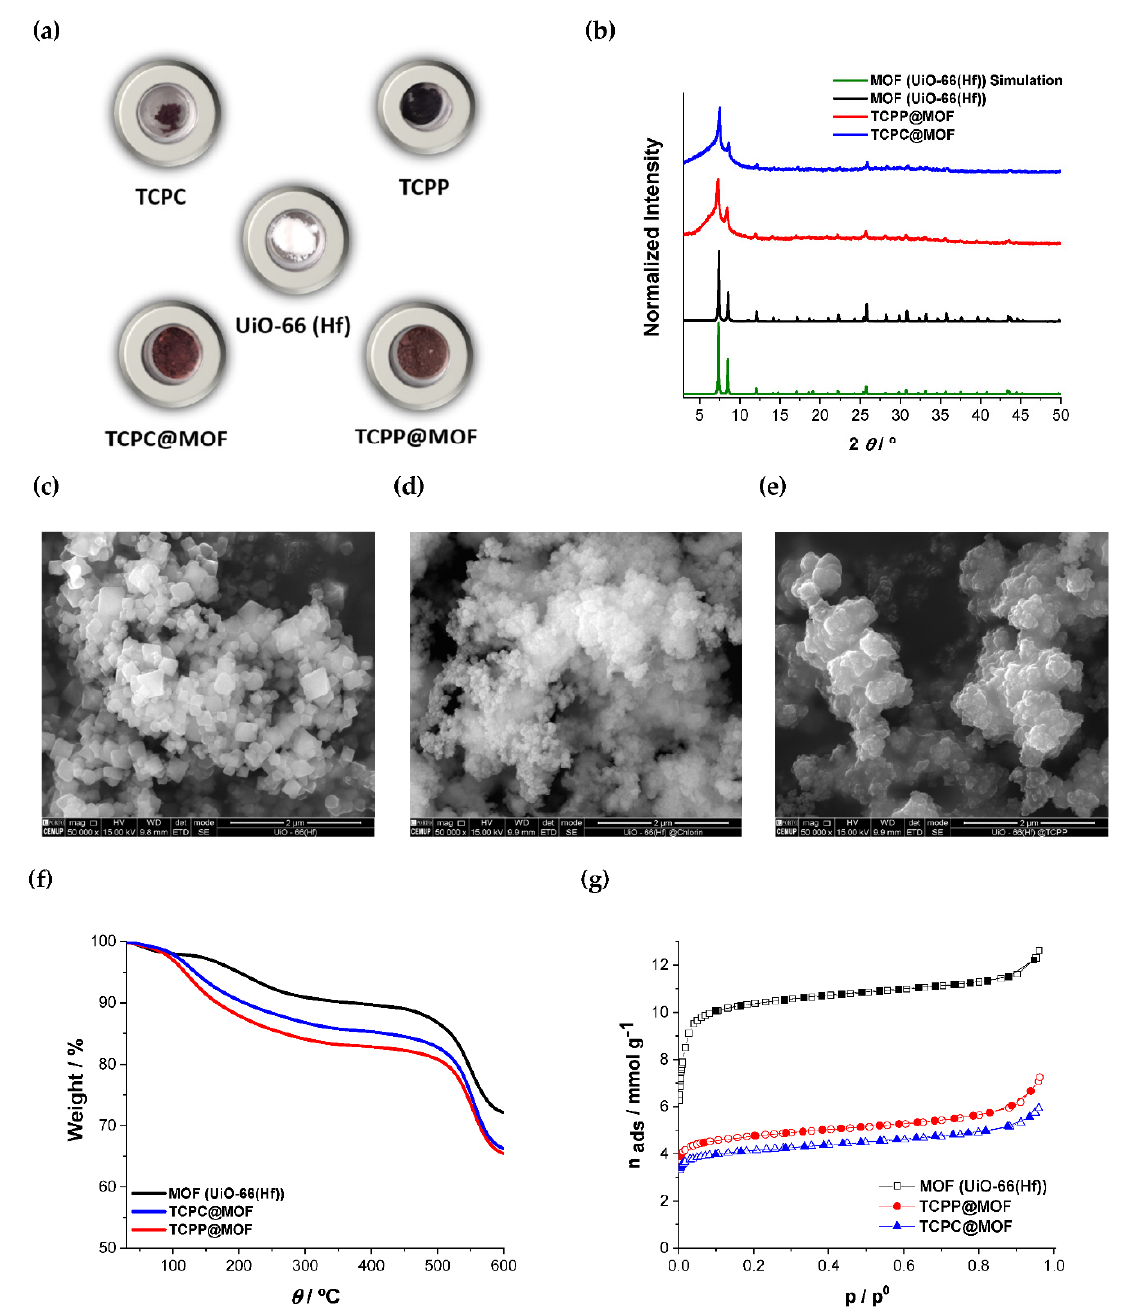
Figure 2. ( a ) Photographs of the prepared ligands (TCPC and TCPP) and MOFs (UiO-66(Hf), TCPP@MOF and TCPC@MOF), in the powder form; ( b ) PXRD patterns for MOF (UiO-66(Hf)) simulated structure [82] and for the prepared MOFs: UiO-66(Hf), TCPC@MOF and TCPP@MOF prepared by one-pot solvothermal reaction; ( c – e ) SEM images of UiO-66(Hf), TCPC@MOF and TCPP@MOF, respectively (50,000 × ampliation); ( f ) TGA of UiO-66(Hf) (black), TCPC@MOF (blue) and TCPP@MOF (red) from 30 to 600 ° C performed with a heating rate of 5 ° C/min in a 200 cm 3 /min N 2 flow stream; and ( g ) N 2 adsorption-desorption isotherms determined at − 196 ° C for UiO-66(Hf), TCPC@MOF and TCPP@MOF (empty and filled symbols correspond to adsorption and desorption, respectively).